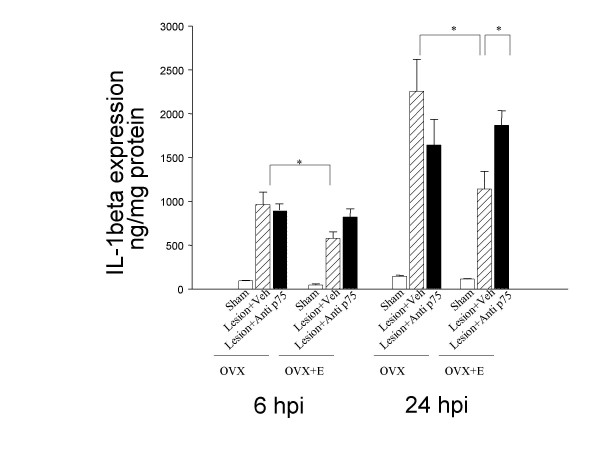
IL-1β regulation by lesion and estrogen treatment: Olfactory bulb lesions significantly increased local IL-1β expression at 6 and 24 hours post injury (6 hpi, 24 hpi). Estrogen treatment (OVX+E) attenuated IL-lβ at 6 hpi, and this effect was more pronounced at 24 hpi. At 24 hpi, anti-p75NTR treatment abolished estrogen's effects on IL-1β. Anti-p75NTR had no effect on IL-1β expression in control pellet-replaced (OVX) animals. Bars represent means ± SEM, n = 6 per group. Sham: Sham lesion, Lesion+Vehicle: NMDA injection with pre immune serum, Lesion+Anti p75: NMDA injections with anti p75NTR antibodies. *:p < 0.05.